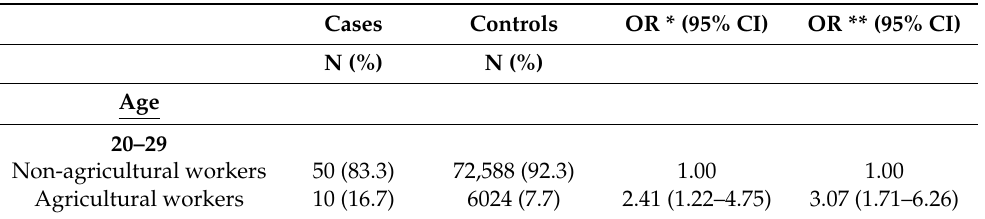
Table 3. AKF mortality among Brazilian southern and midwestern agricultural workers, according to 10-year age strata,